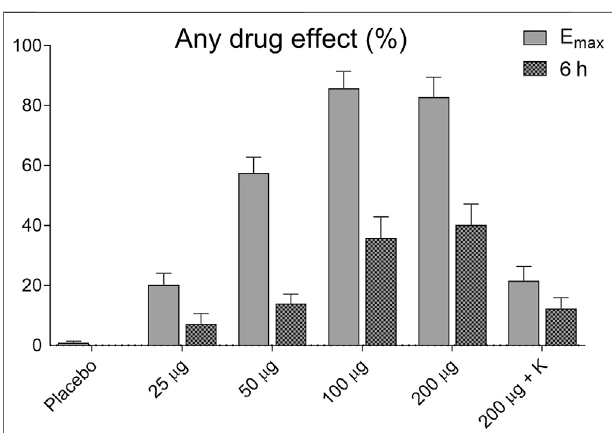
FIGURE 2 | Acute subjective effects of LSD. LSD dose-dependently induced subjective effects, measured as “ any drug effects, ” on the VAS. The data show the subjective effects as maximal response and at 6 h after drug administration when the empathy test was performed. The data are expressed as the mean ± SEM in 16